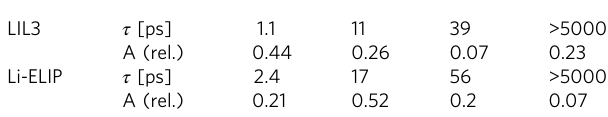
Fig. 3 Ultrafast transient-absorption data measured after excitation of Chl in LIL3 and Li-ELIP. Transient-absorption spectra of LIL3 ( a ) and Li-ELIP ( b ) immediately after excitation (dashed) and at 4 ps (solid). LIL3 and Li-ELIP proteins were excited at 670 nm and 675 nm, respectively. c The rise of the carotenoid signal after Chl excitation was measured at the maximum of the S 1 – S n band at 587 nm for LiL3 and 584 nm for Li-ELIP. d Decay of excited Chl monitored at 685 nm; the blue line shows Chl dynamics for unquenched ELIP2 for comparison. e Uni fi ed scheme of energy transfer pathways in LIL3 and Li- ELIP. The model assumes non-selective excitation of a pool of four Chl (red wavy arrow). The green double arrows represent the main Chl-to-carotenoid energy transfer quenching channel. Solid arrows denote relaxation processes associated either with the equilibration between Chl pools (blue) or with the decay of the carotenoid S 1 state (orange). The numbers correspond to the time constants (in ps) associated with each process in LIL3 (Li-ELIP). See Supplementary Fig. 8 for details. Table 1 Time constants and relative contributions at 680 nm of Chl decay components obtained in LIL3 and Li-ELIP following excitation into Q y band of